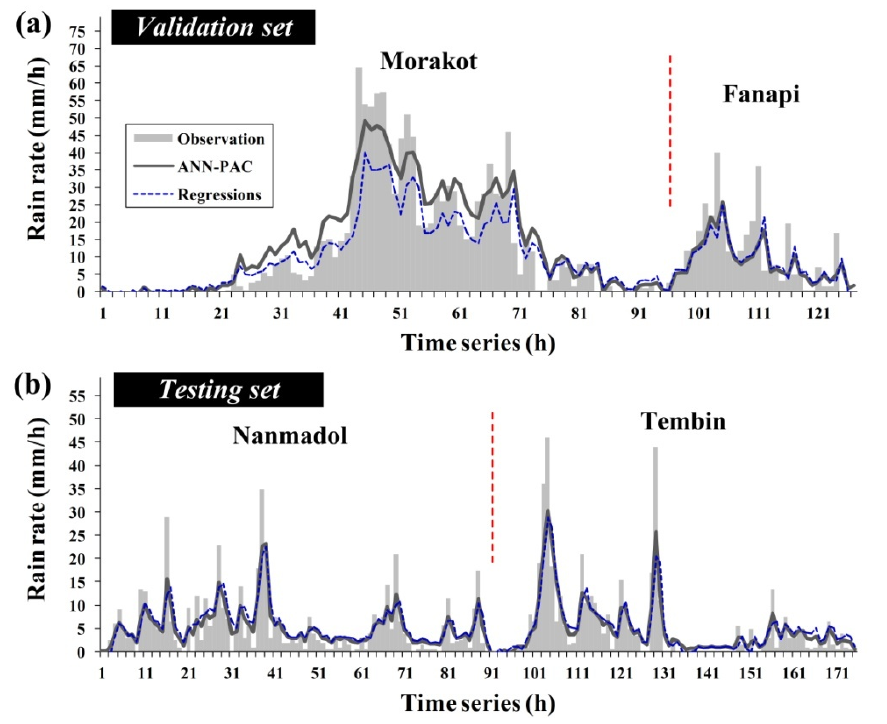
Figure 6. Simulation results of 1-h-ahead predictions for hyetograph using: ( a ) the validation set and ( b ) the testing